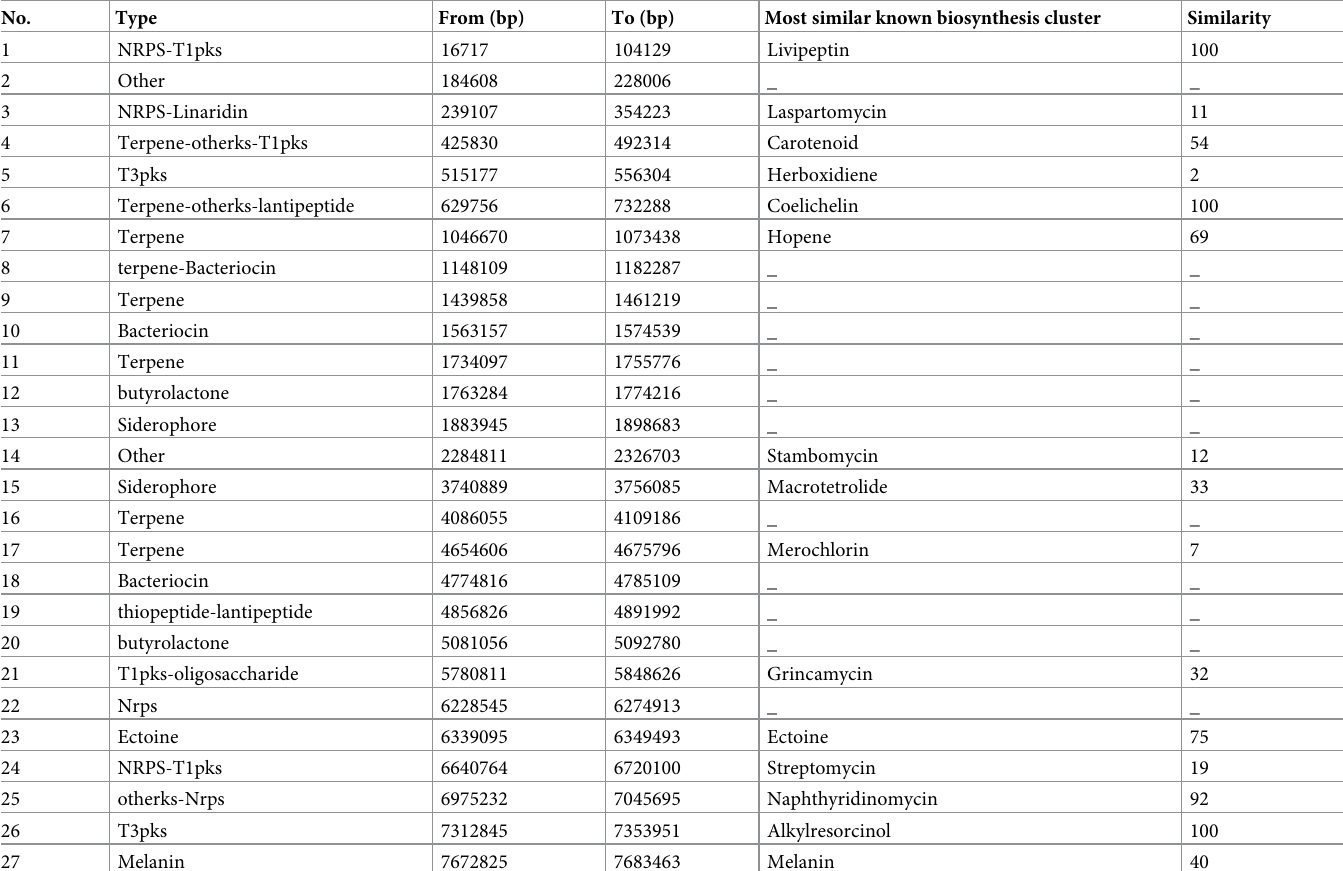
Table 4. Putative gene cluster coding for secondary metabolites in S . niveus SCSIO 3406 via antiSMASH.